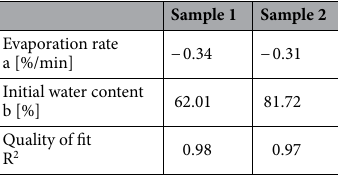
Table 2. Fitting parameters and errors of the linear fits of the form f (x) = ax + b of the water evaporation.